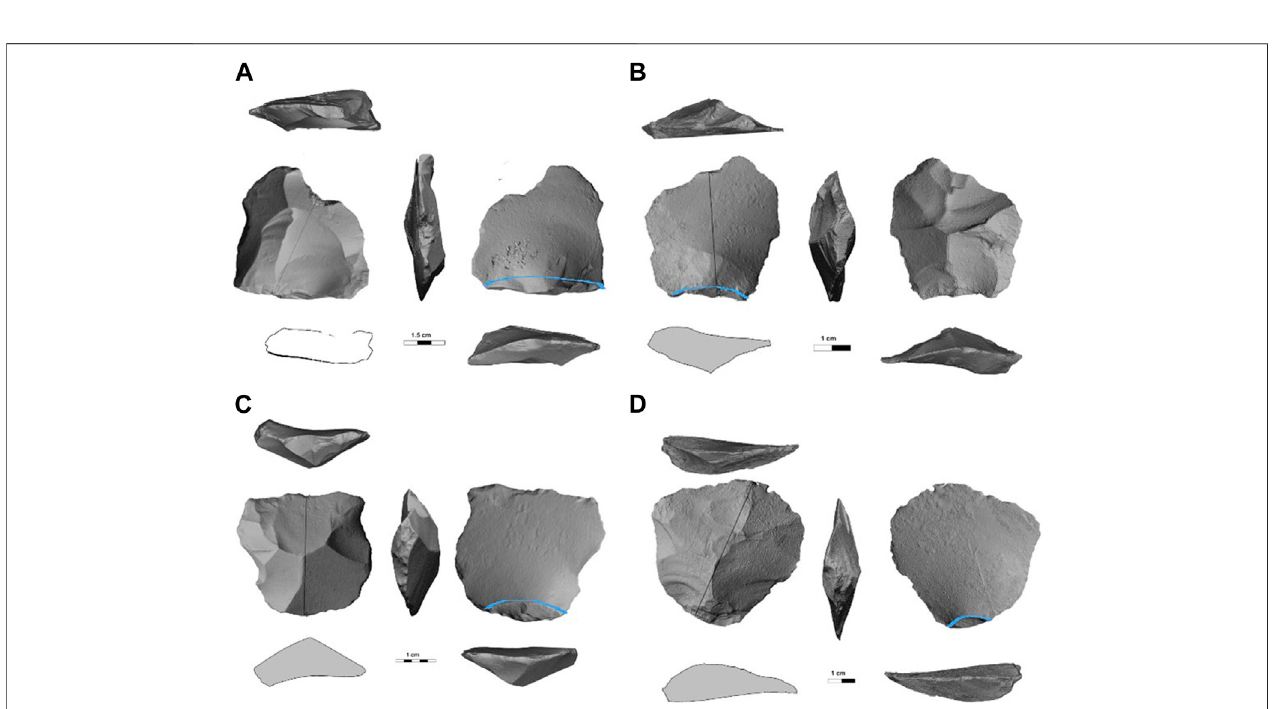
FIGURE 12 | (A – D) Blanks produced from prepared cores, from Jaljulia. The bulb of percussion is highlighted by a blue line.